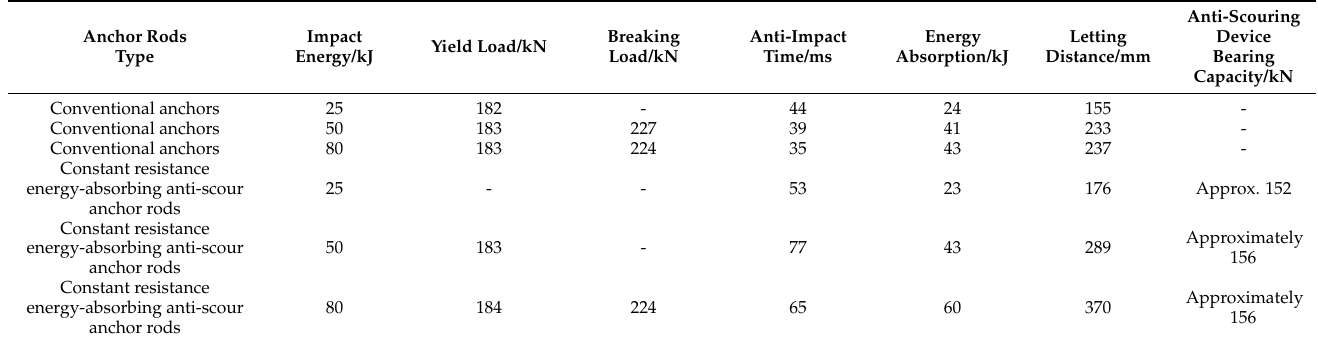
Figure 9. Anchor energy – absorption – displacement curve. Table 2. Mechanical properties of anchor rods at different impact